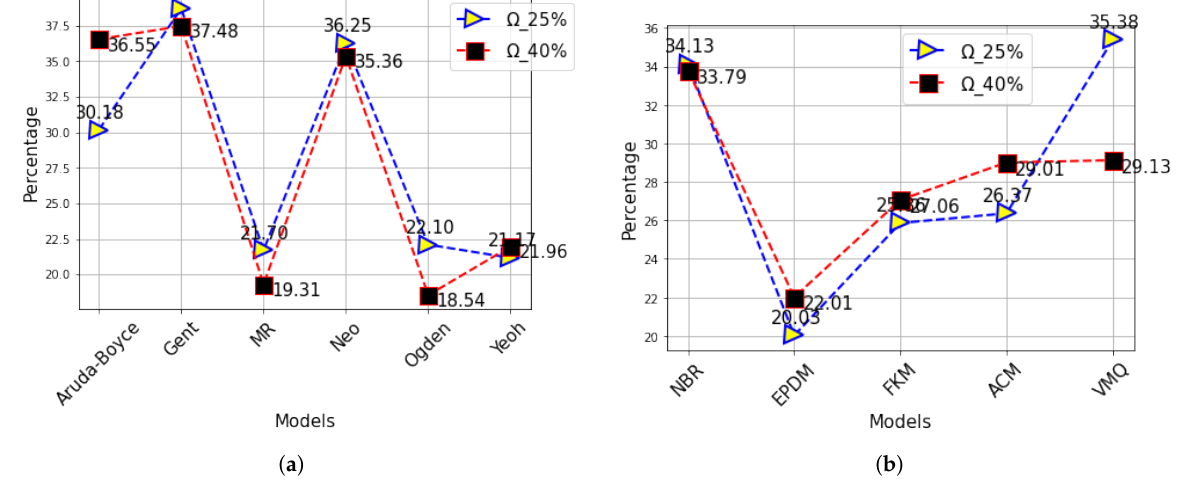
Figure 10. Weighted averaged error assessment ( a ) hyperelastic models ( b )